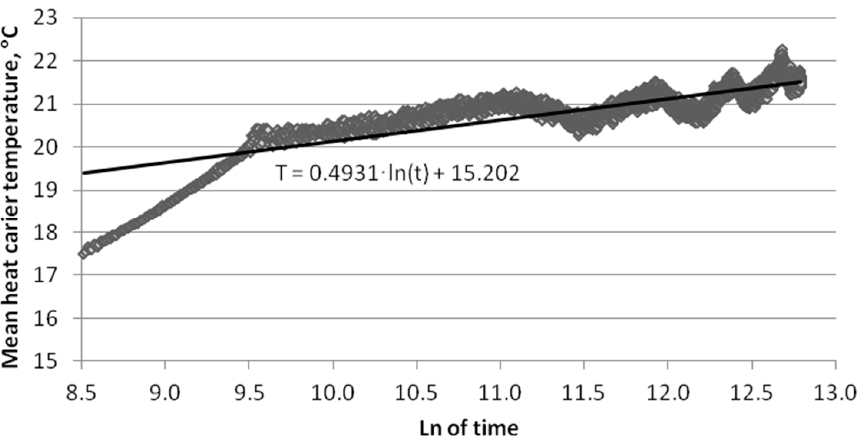
Figure 10. TRT results with the measurement data averaging every 1 min.